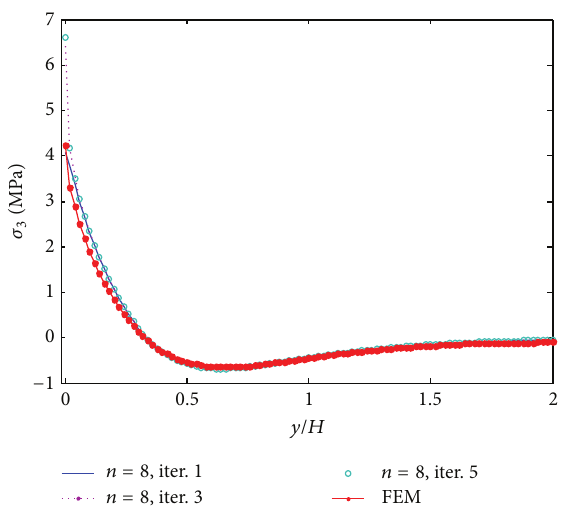
Figure 4: 𝜎 3 distribution of [PZT/0 4 /90 4 ]s laminate at the interface of 𝑧/𝐻 = 1/6 from different iterations, under 0.1% uniaxial strain.